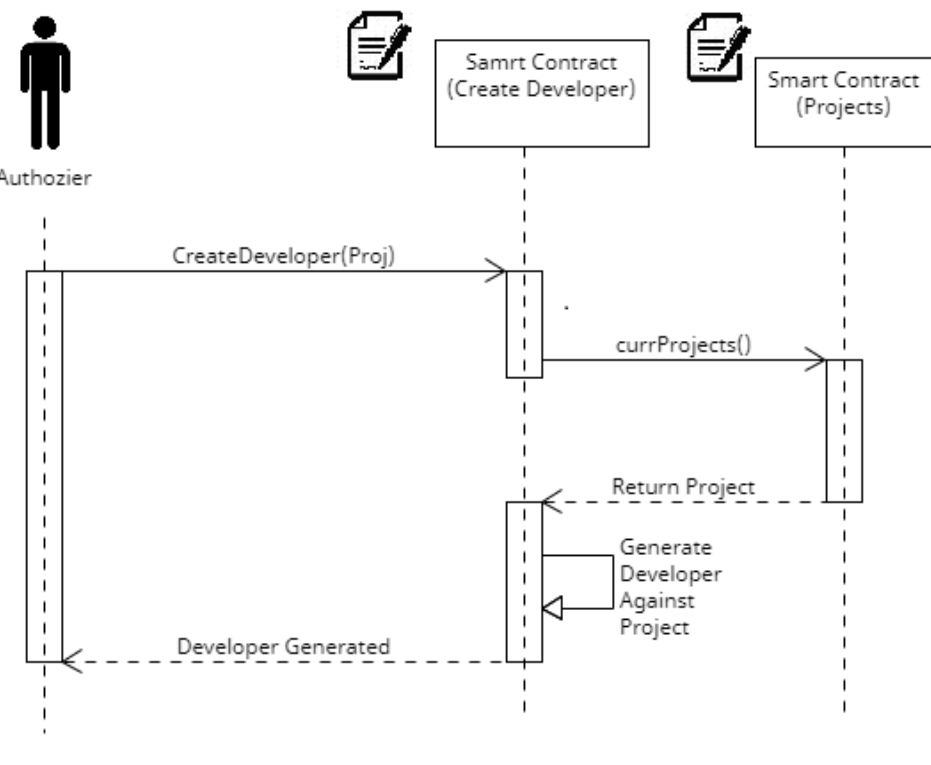
Figure 10. SD for creating developer.